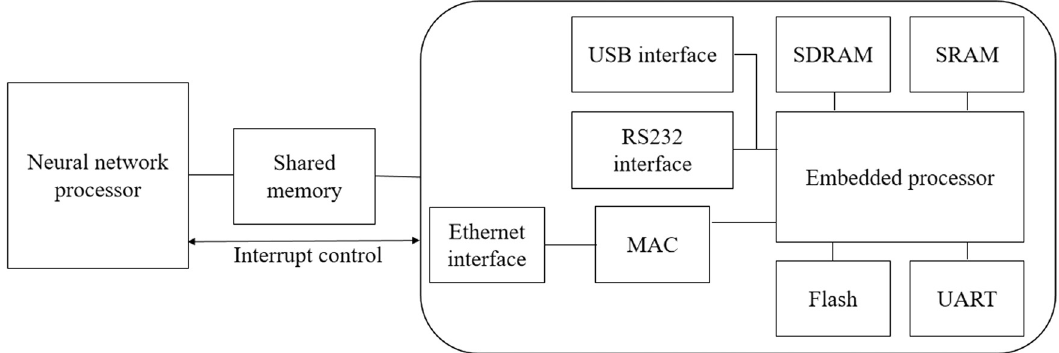
Figure 3: System structure of shared